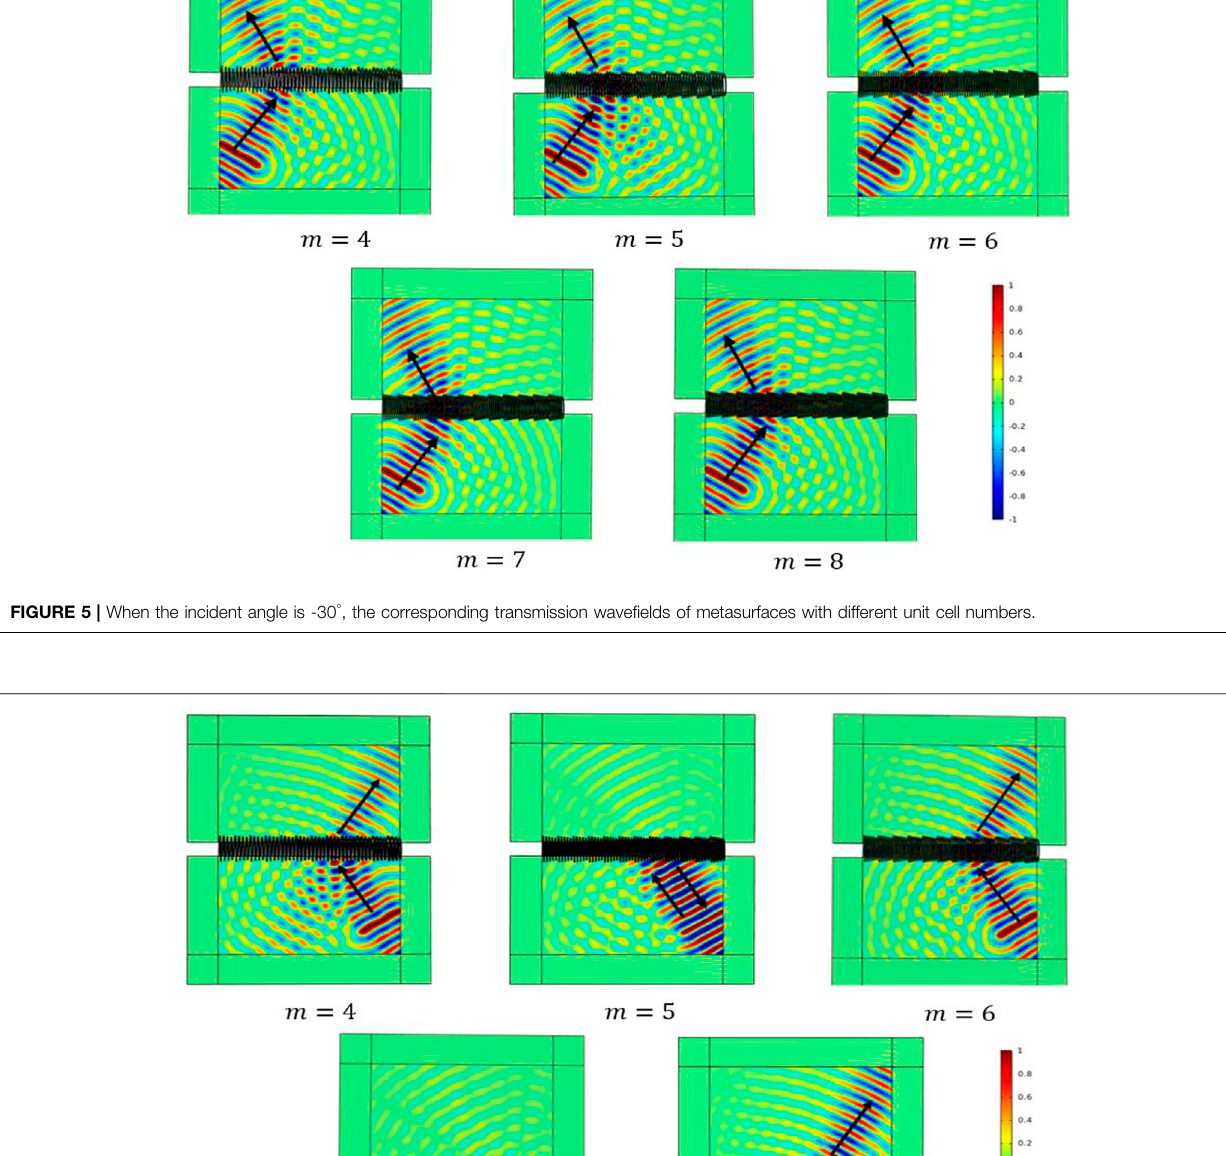
angle of incidence, no higher order diffraction is produced, so we reset the incident angle of 45 ° . The simulation results are shown in Figure 7 . When m is an even number, there is a clear